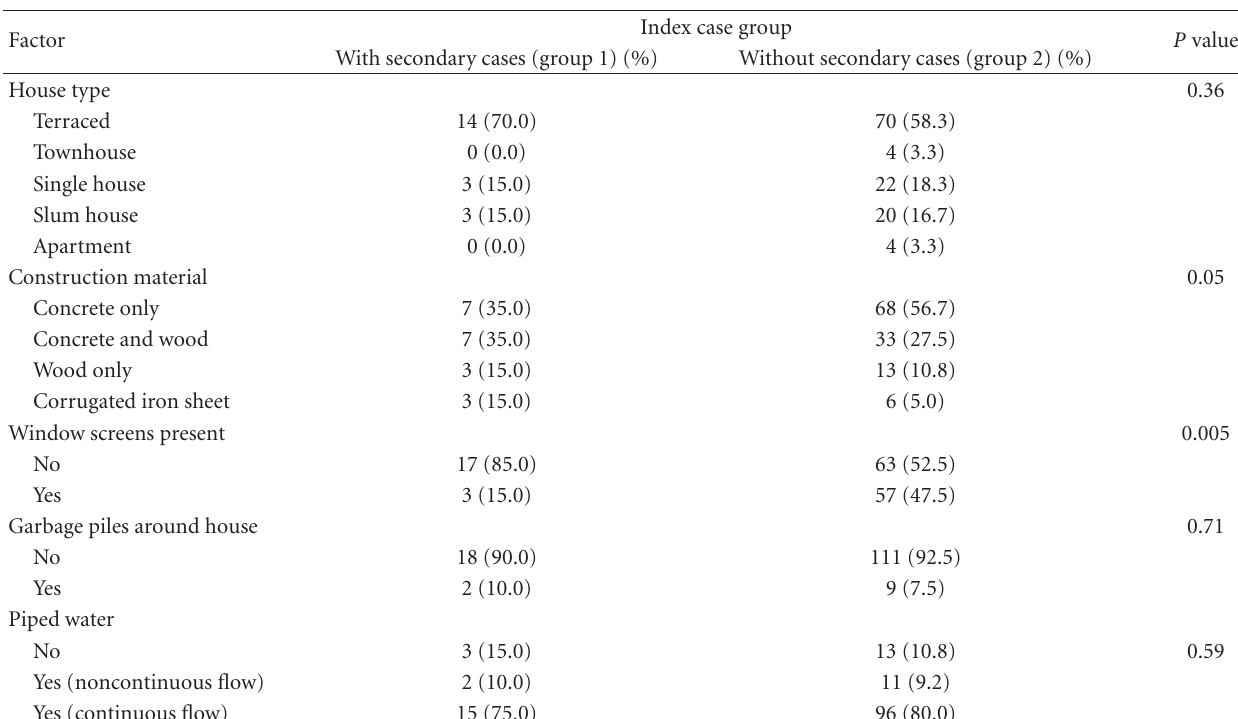
Table 3: Comparison of environmental characteristic of index case houses.